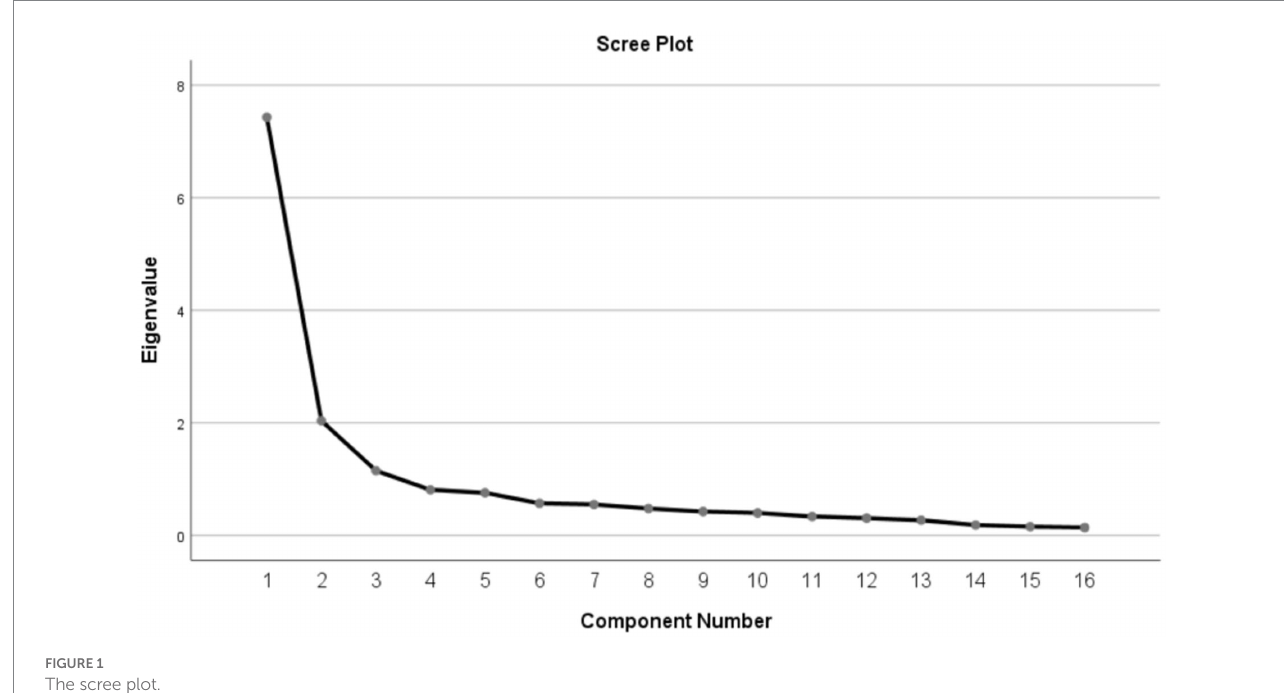
FIGURE 1 The scree